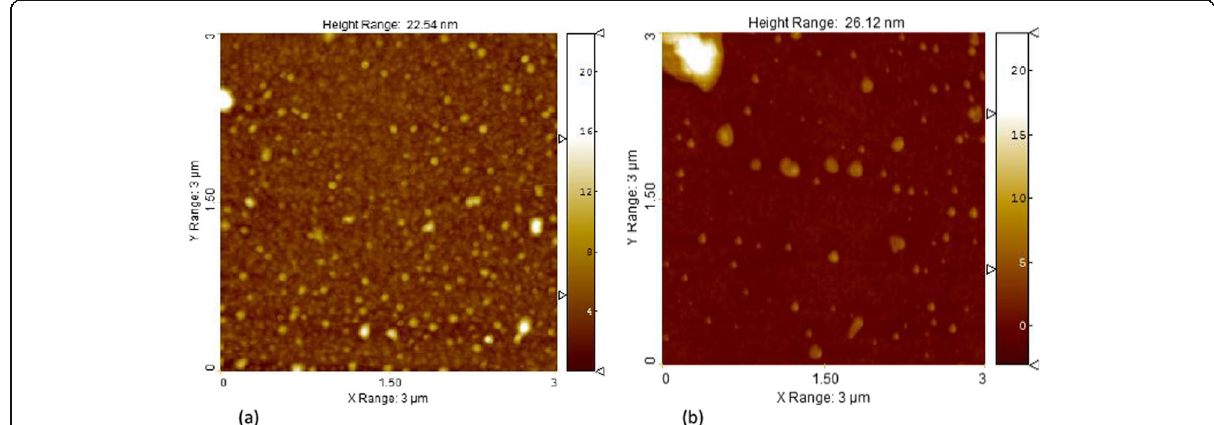
Fig. 3 AFM images of a Fe 2 O 3 − X nanometric film obtained at 0.5 Pa by 5000 laser pulses, R max =22.846 nm. b Cr 3 − X O 3 − Y nanometric film obtained at 0.5 Pa by 4000 laser pulses, R